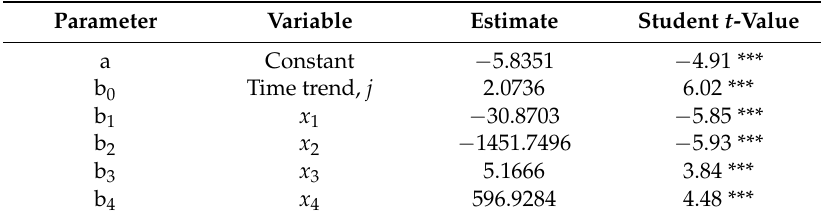
Table 5. Estimation of the parameters in Equation (19f).